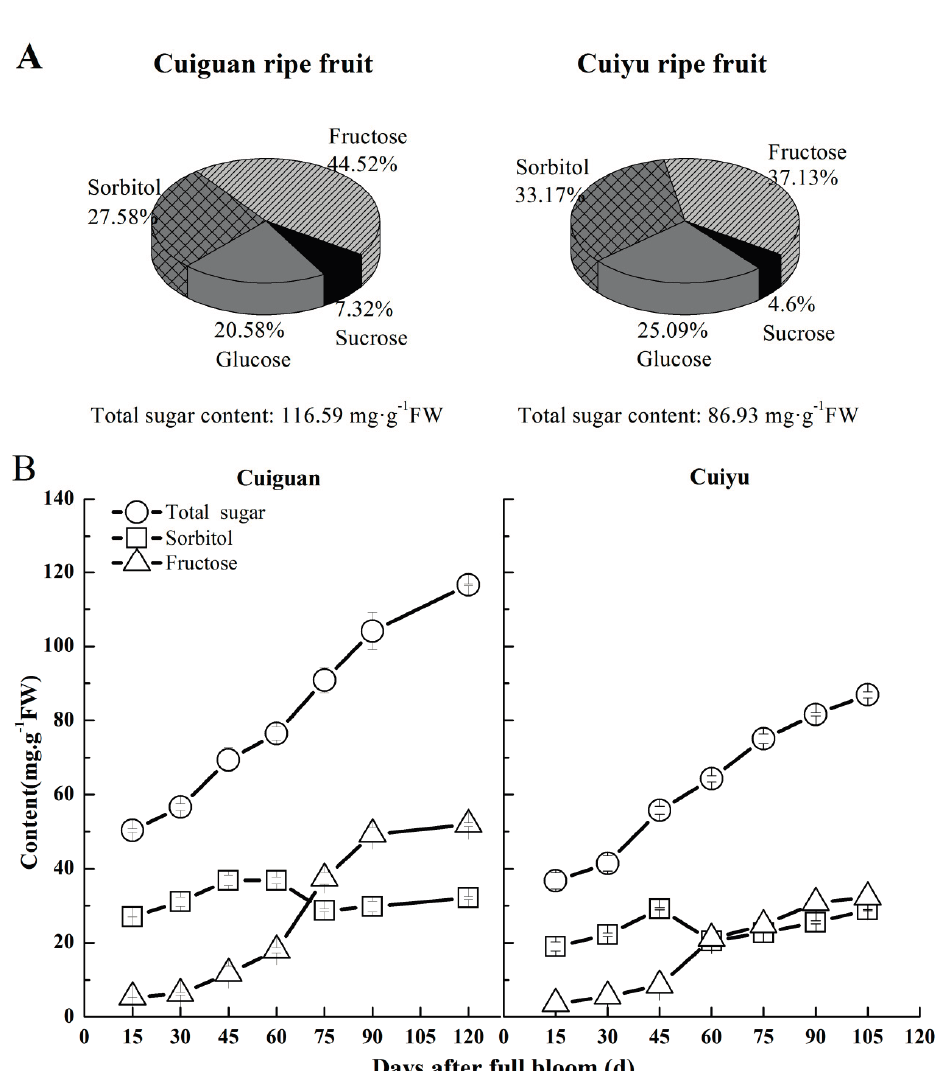
Figure 5. Sugar content and composition in ripe fruit ( A ) and changes in content of total sugars ( ○ ), sorbitol ( □ ) and fructose ( ∆ ) during fruit development ( B ) in “Cuiguan” and “Cuiyu” pears. Error bars indicate the standard error (SE) from three biological